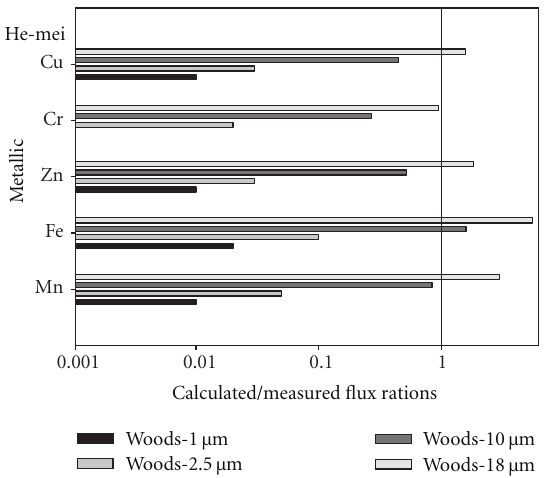
Figure 4: It displays the average calculated/measured flux ratios by using Woods models in the prediction of ambient air metallic elements dry deposition for various particle sizes (1 μ m, 2.5 μ m, 10 μ m, and 18 μ m) at He-mei sample